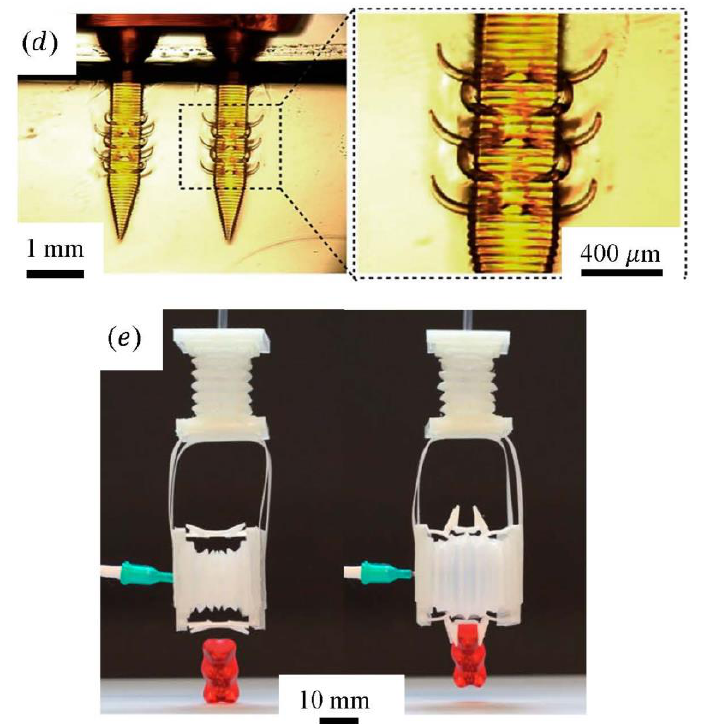
Figure 2. Controllable 4D-printed systems ( a ) A combined sensor and 3D-printed pneumatic muscle (reproduced from [66] with the permission of Frontier under Creative Commons CC-BY licence); ( b ) An embedded piezoelectric sensor in the hydrogel actuator (reproduced [67] with the permission of SPIE); ( c ) A sweating 4D-printed system with thermoregulation pores (reproduced from [61] with the permission of The American Association for the Advancement of Science); ( d ) The 4D-printed bioinspired microneedles with stiffness control (reproduced from [62] with the permission of John Wiley and Sons); ( e ) A buckling-induced 4D-printed active skin (reproduced from [60] with the permission of the Nature Publishing